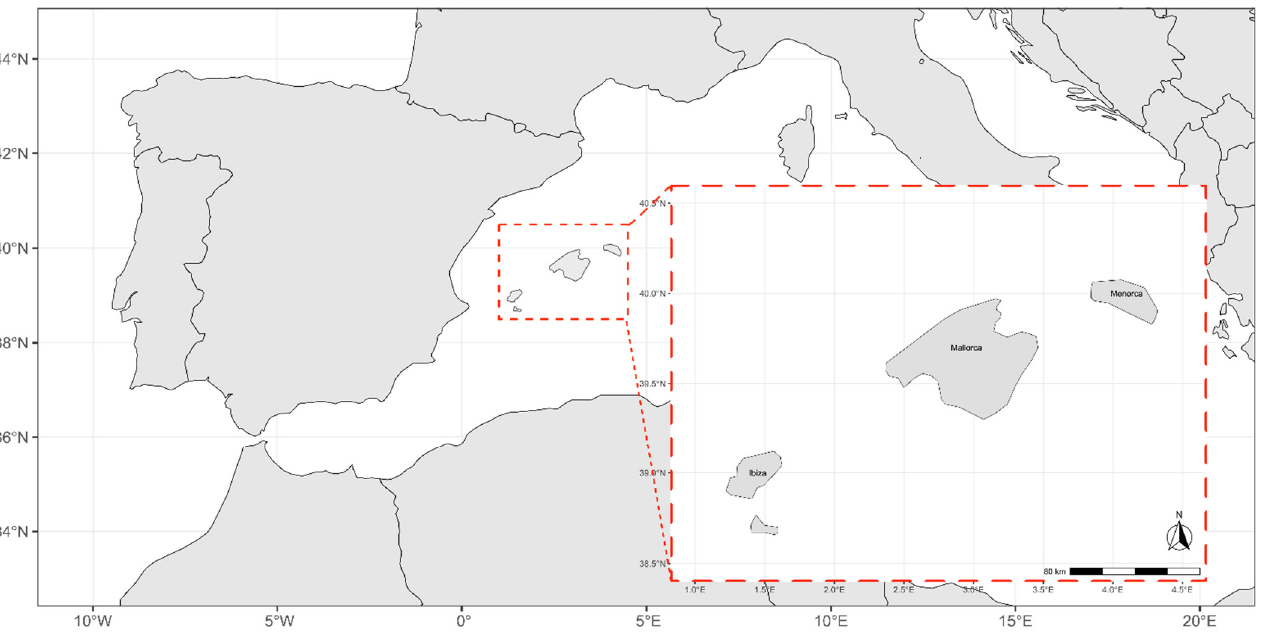
Figure 2. Overview map of the study area with main islands included: Mallorca, Menorca, Ibiza, and Formentera (below Ibiza).